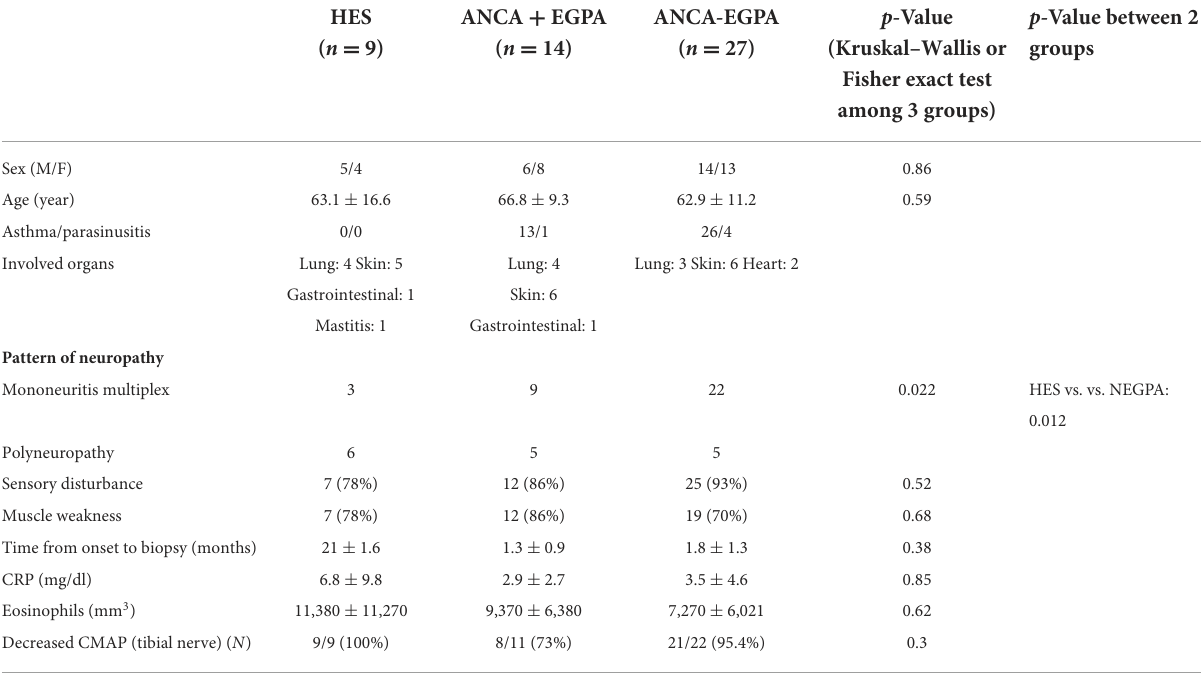
TABLE 1 Patient